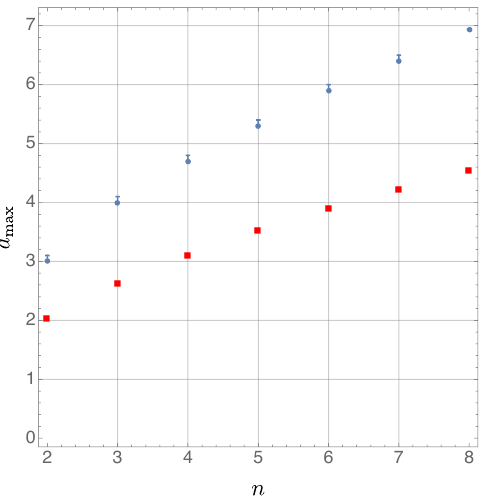
Figure 3 . a max (represented by the blue disks) and a ergo (represented by the red squares) as a function of n . The error bars in determining a max are computed via the failure of our code to (cid:12)nd solutions for the upper range of a .